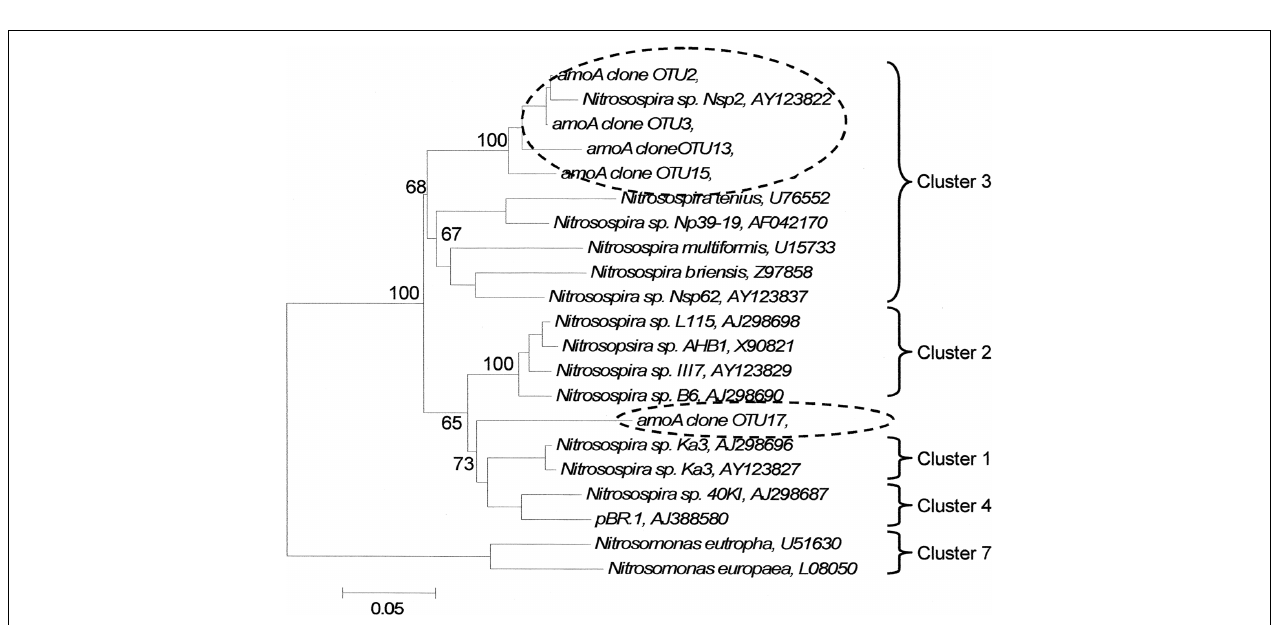
FIGURE 4 | Phylogenetic tree of cloned amoA operational taxonomic units that significantly delineated land-use as determined by indicator species analysis. Broken ovals highlight cloned sequences from this study. The label of the sequence used in the analysis is followed by their respective